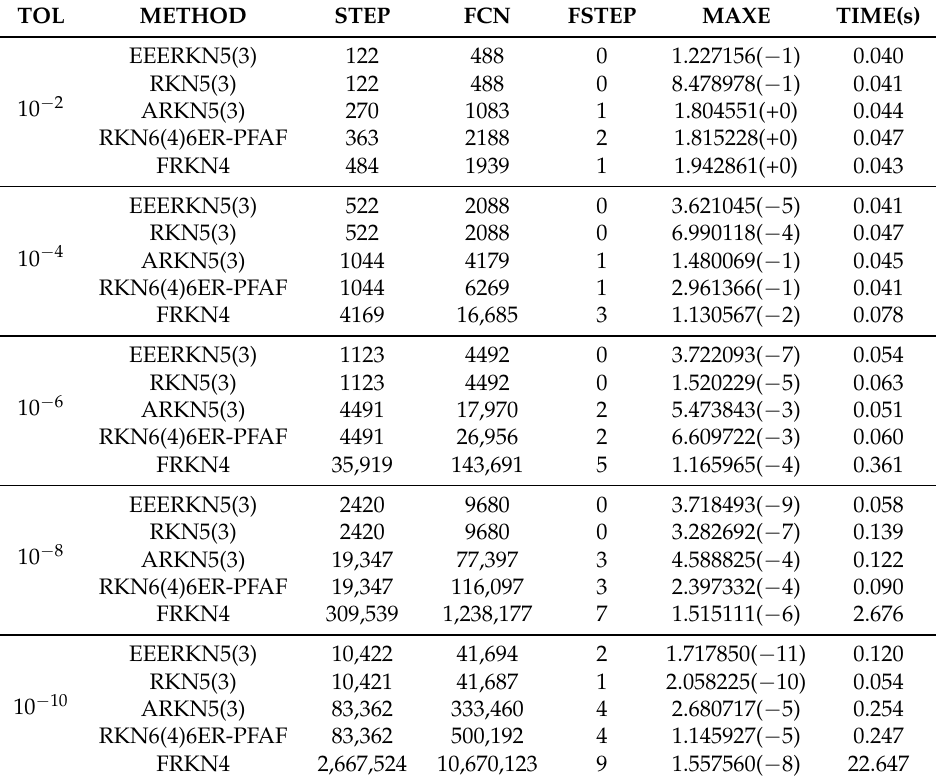
Table 3. Numerical results for Problem 2.